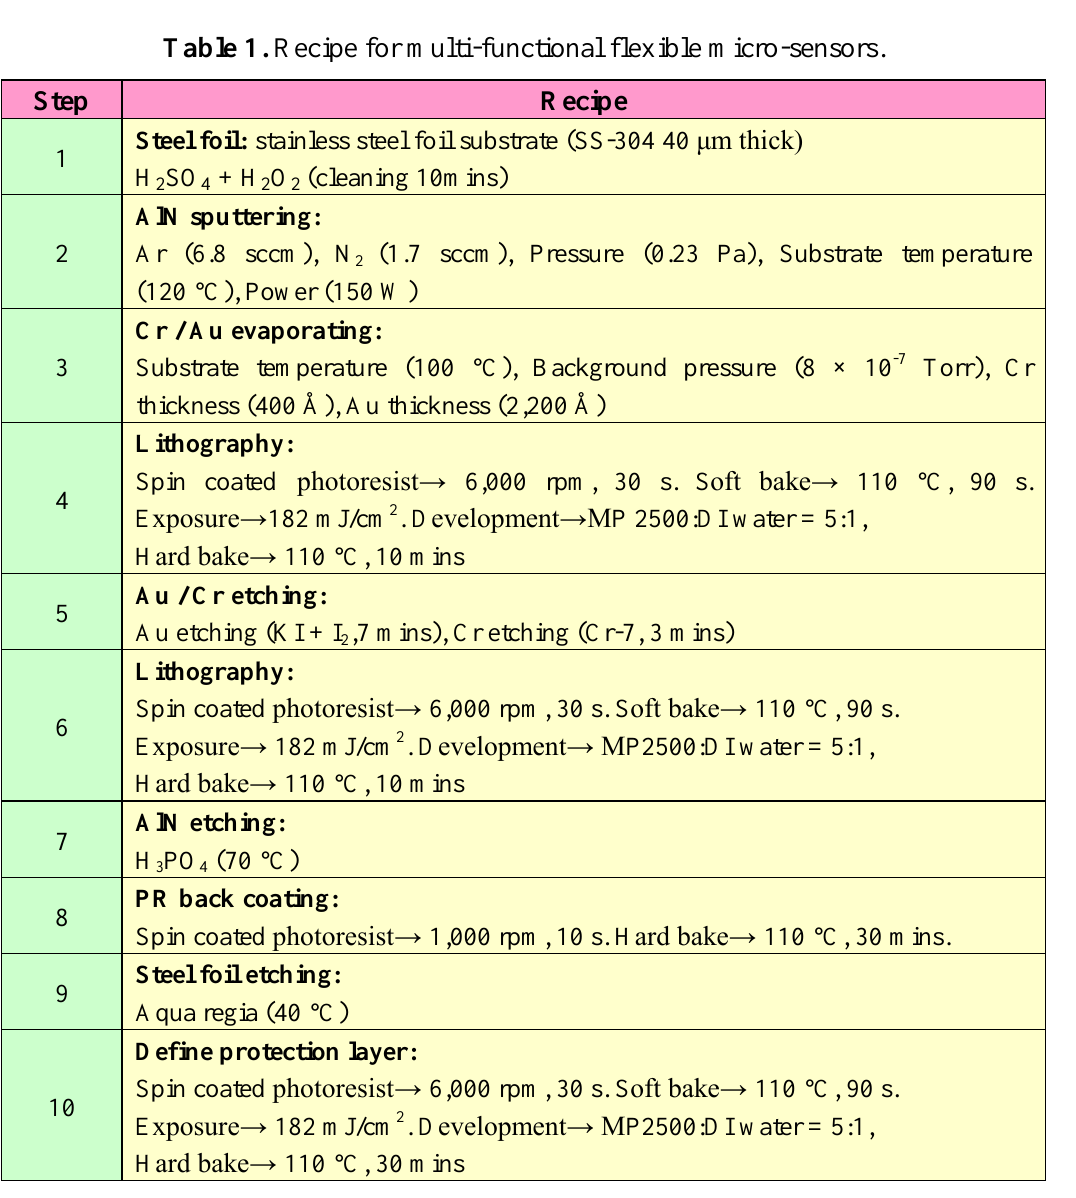
Figure 6. SEM image of micro temperature/ flow and voltage